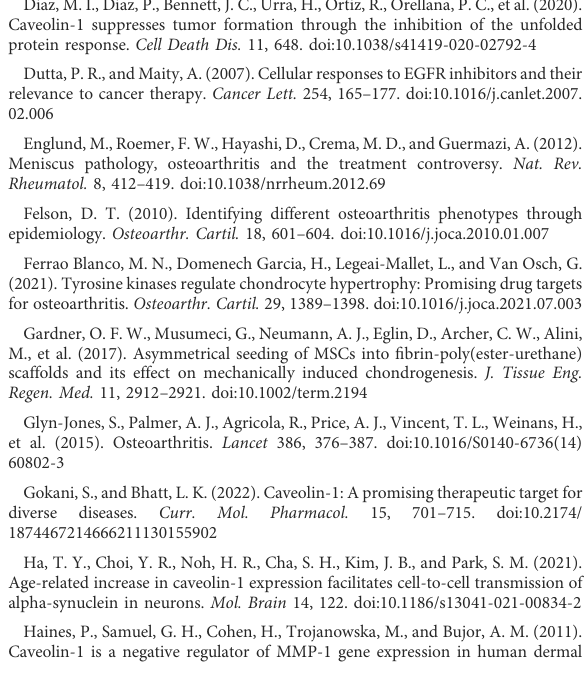
SUPPLEMENTARY TABLE S6 GO and KEGG analysis of early responsive genes. SUPPLEMENTARY TABLE S7 GO and KEGG analysis of late responsive